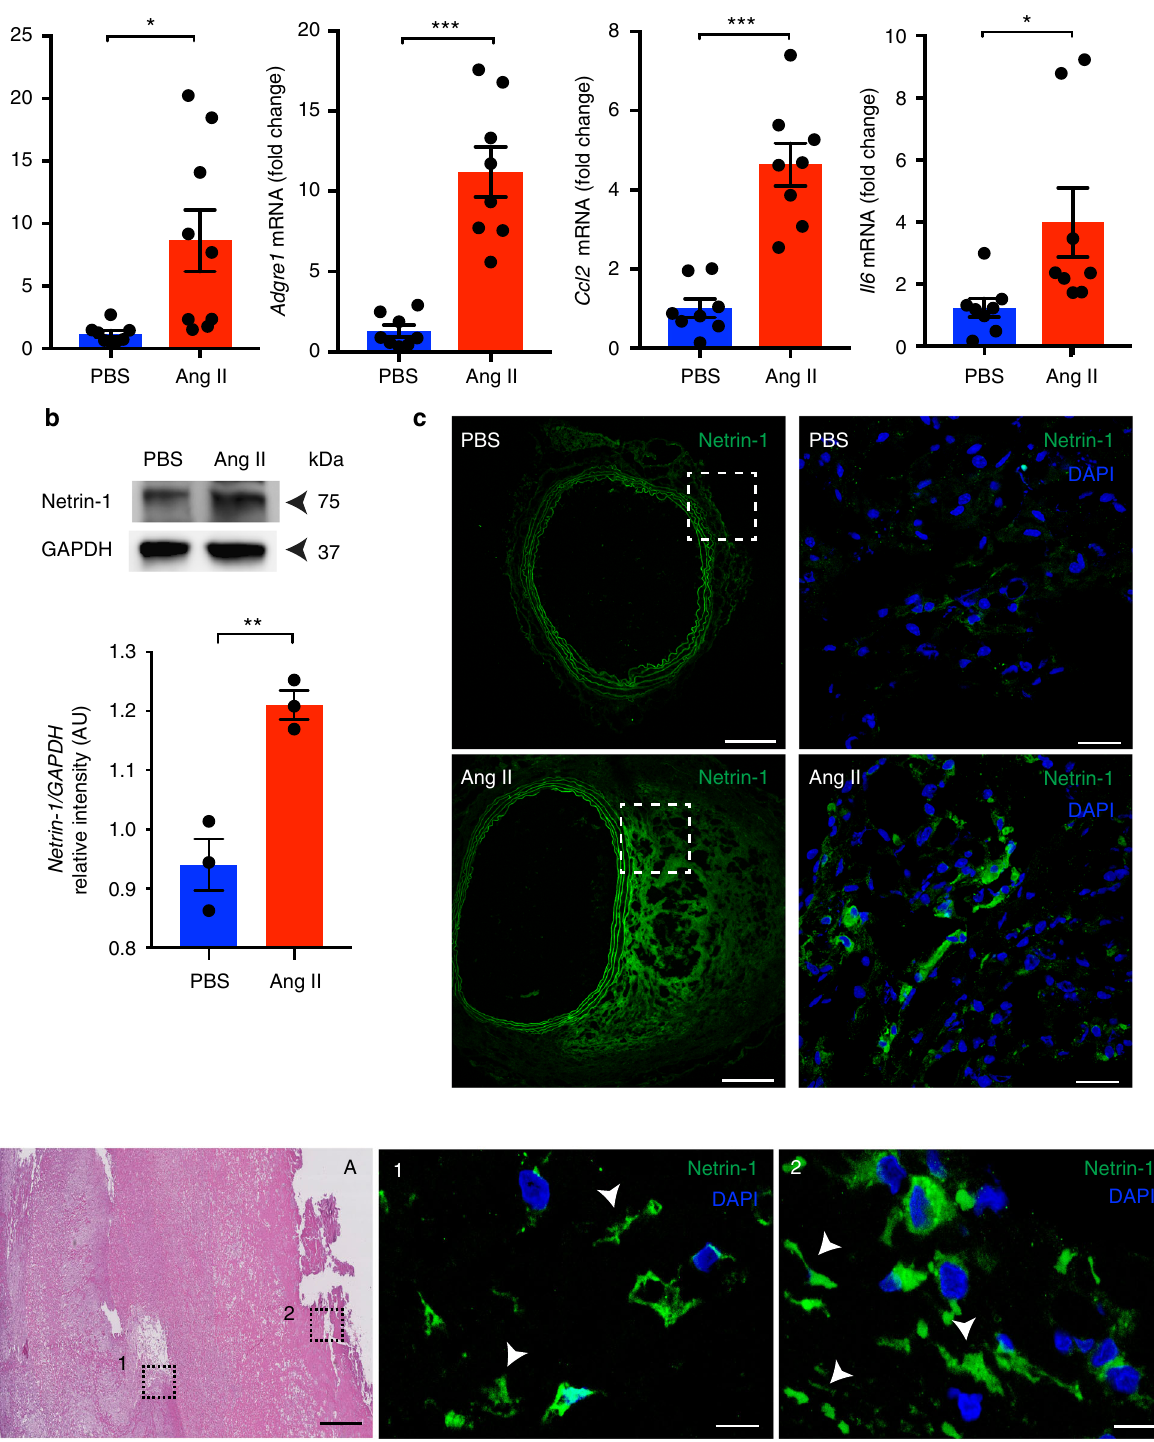
Fig. 1 Netrin-1 is highly expressed in human and murine AAA. a Quantitative PCR analysis of Ntn1 , Adgre1 , Ccl2, and Il6 mRNA levels isolated from aortas of ApoE − / − mice exposed to PBS or Ang II for 28 days ( n = 8/9 mice per group). * P < 0.05, *** P < 0.001. b Western blot analysis of netrin-1 in aorta extracts normalized to loading control, GAPDH ( n = 3 mice per group). AU arbitrary units. ** P < 0.01. Representative microscopy staining of netrin-1 and cell nuclei (DAPI, blue) in magni fi ed aortic sections (dashed box) from PBS and Ang II infused ApoE − / − mice ( c ) (whole aortic section is shown in left top and bottom, scale bar 200 µ m, magni fi ed areas on the right, scale bar 20 µ m) and human specimens ( d ); Hematoxylin and eosin (H&E; scale bar 500 µ m) staining showing magni fi ed sections (1, 2; scale bar 20 µ m); arrows indicate acellular localization of netrin-1; L lumen, A adventitia. Unpaired, two-tailed t - test was used for statistical analysis. Error bars represent